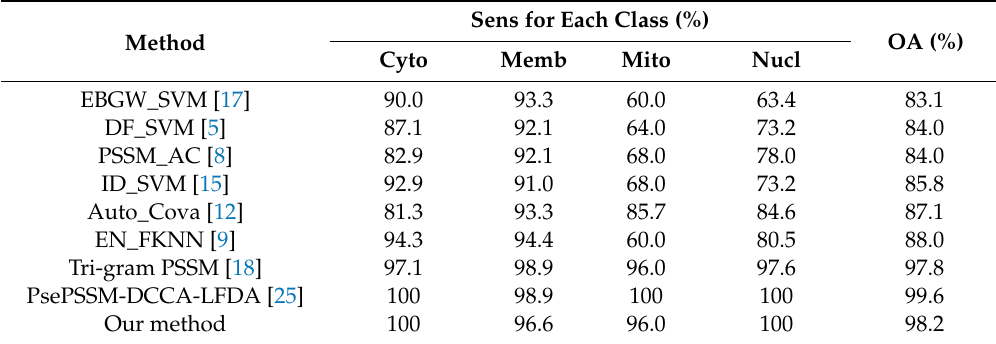
Table 2. Performance comparison of di ff erent methods on the ZW225 dataset.